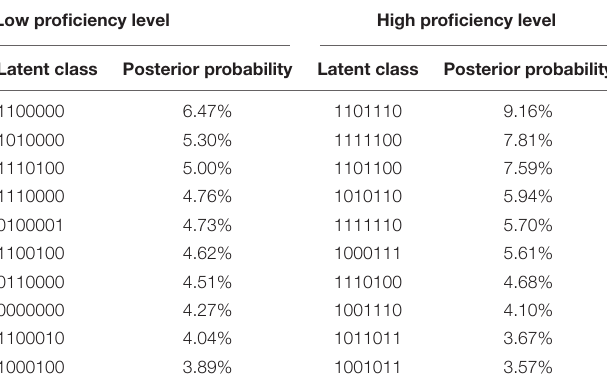
TABLE 10 | Ten dominant latent classes and posterior probabilities at low and high proficiency levels. Low proficiency level High proficiency